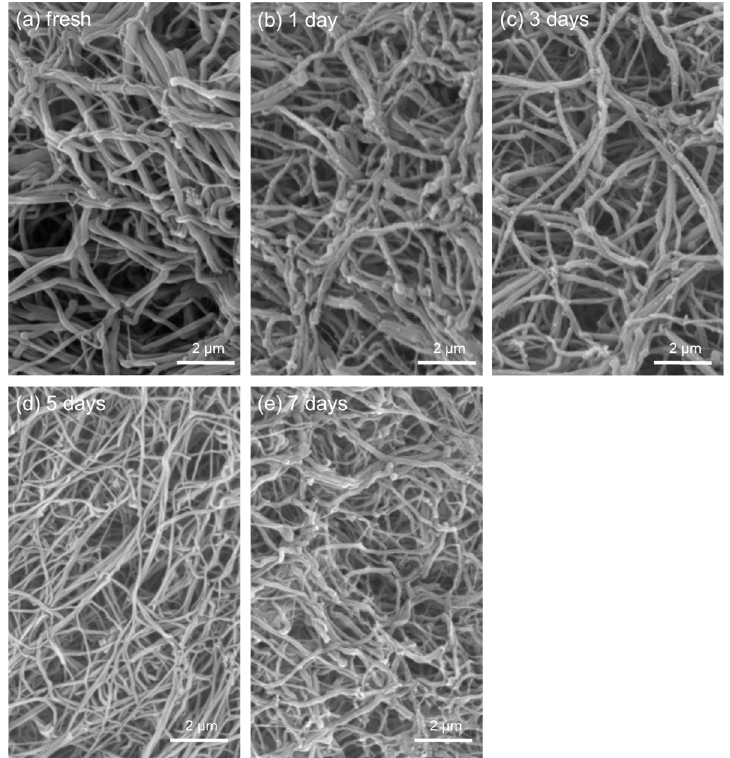
Figure 6. Scanning electron microscopy (SEM) images of fibrin fibers formed in PRFMs prepared from WB samples stored for the indicated periods. WB samples were simultaneously collected from the same donor. Similar findings were obtained in three other